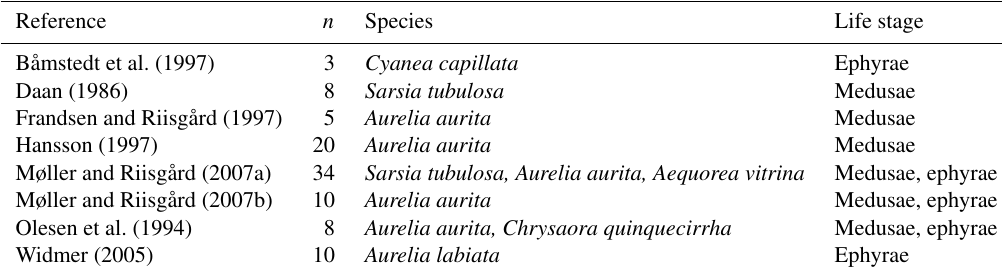
Table A1. Sources and metadata for jellyfish growth rates, including references with associated number of data points, species and life stage used to inform the growth parameter of jellyfish in PlankTOM11.